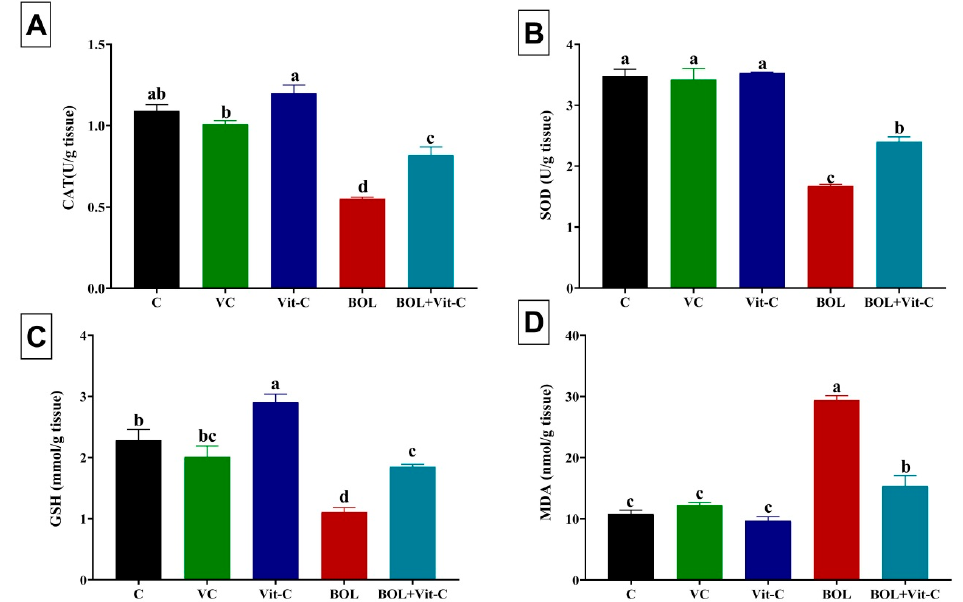
Figure 2. Changes in oxidative stress and lipid peroxidation indicators in boldenone (BOL) (5 mg/kg bwt/once a week, 8 weeks) and/or vitamin C (Vit-C) (120 mg/kg b.wt/daily, 8 weeks) treated adult male Wister rats. ( A ) Catalase, CAT; ( B ) Superoxide dismutase, SOD; ( C ) Reduced glutathione, GSH; and ( D ) Malondialadehyde, MDA. Data are expressed as the mean ± SE ( n = 8 replicates). Columns carrying different superscripts (a, b, c, and d) are significantly different (One-way ANOVA) ( p <